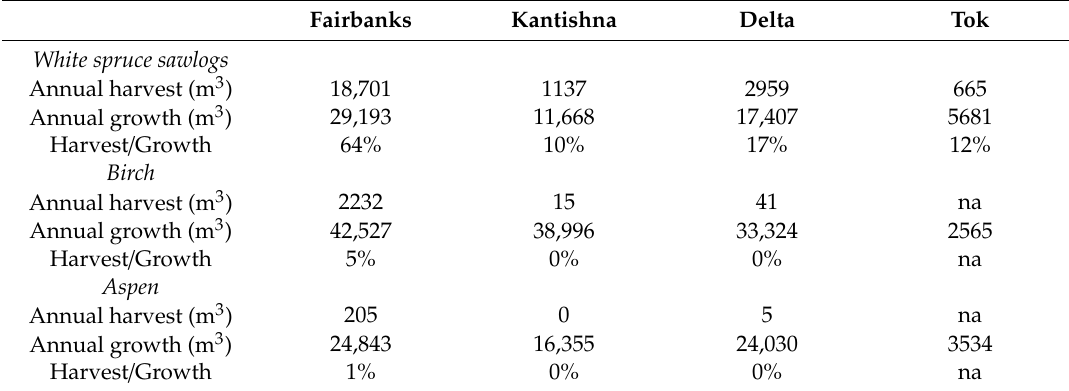
Table 7. Comparison between volume harvested and annual growth for each product type and management